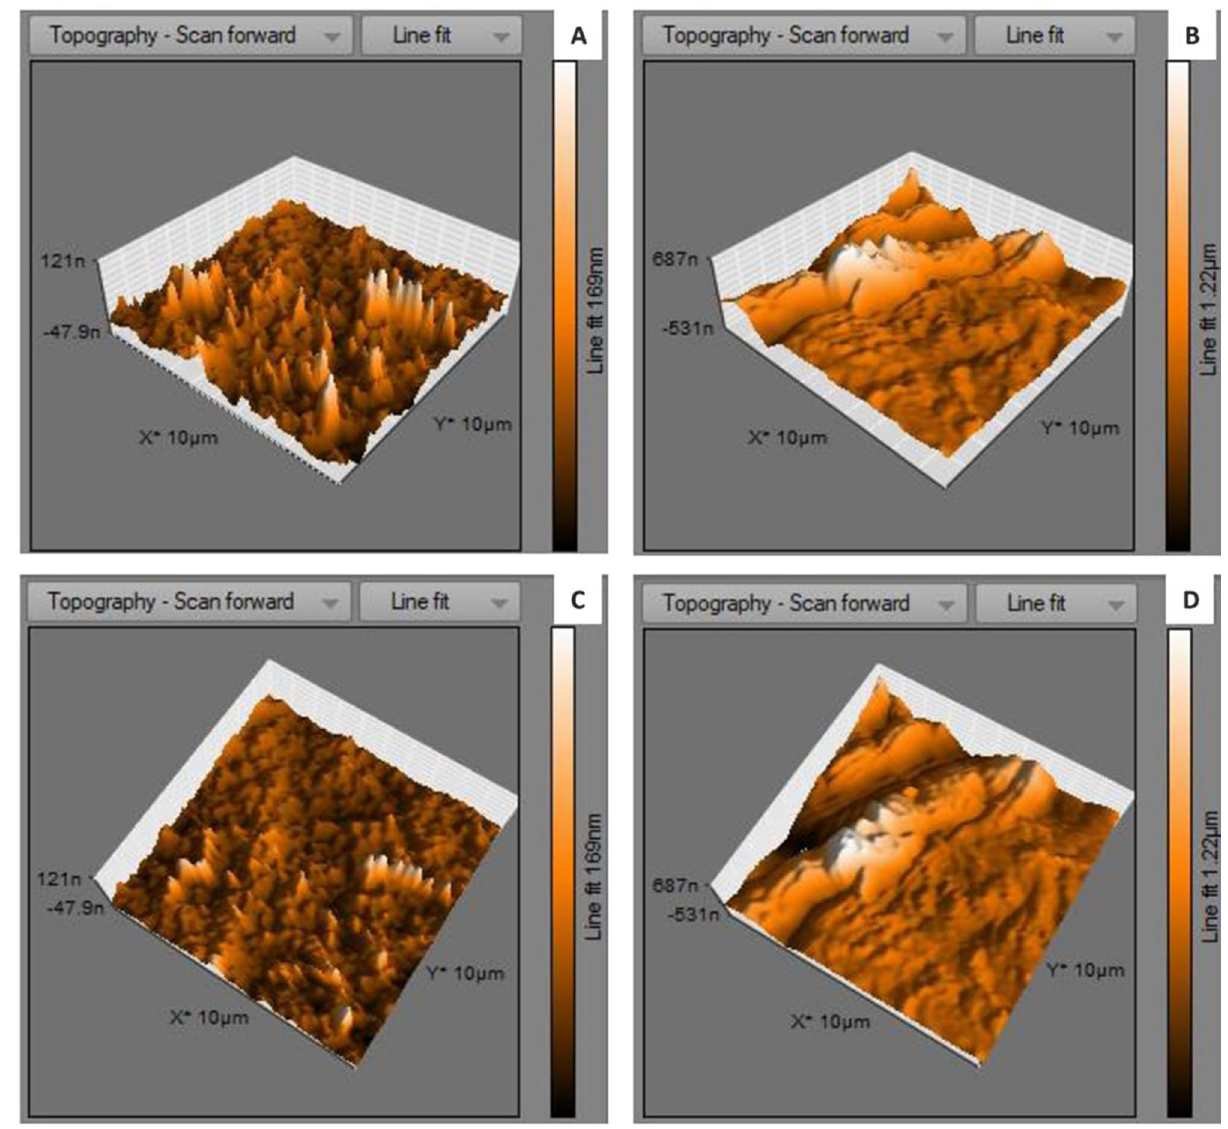
Figure 28. ( A ) Three-dimensional view of control (untreated) LDPE sheet of 10 µm 2 area; ( B ) Three- dimensional view of U. africanum treated LDPE sheet; ( C ) Topographical view of control (untreated) LDPE sheet; ( D ) Topographical view of U. africanum treated LDPE sheet with erosions on its